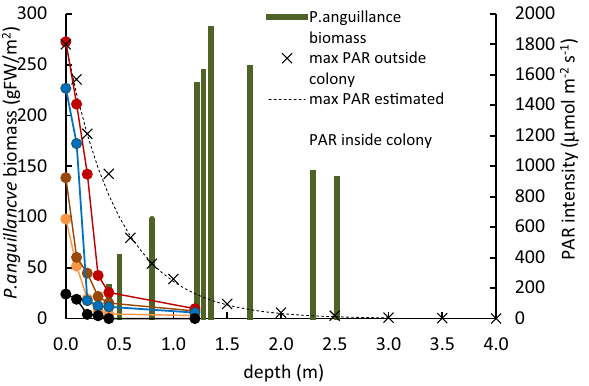
Figure 1. Diurnal distribution of PAR and biomass of P. anguillanus at different depths in Lake